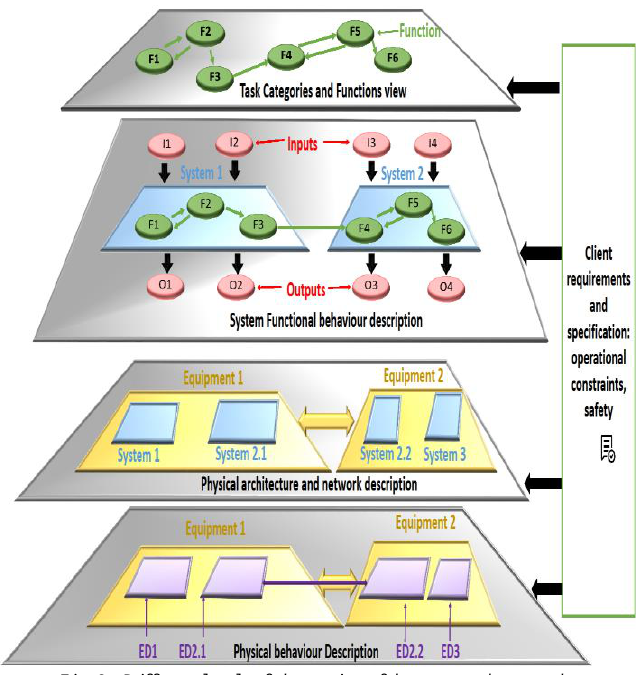
Fig. 2 - Different levels of abstraction of the proposed